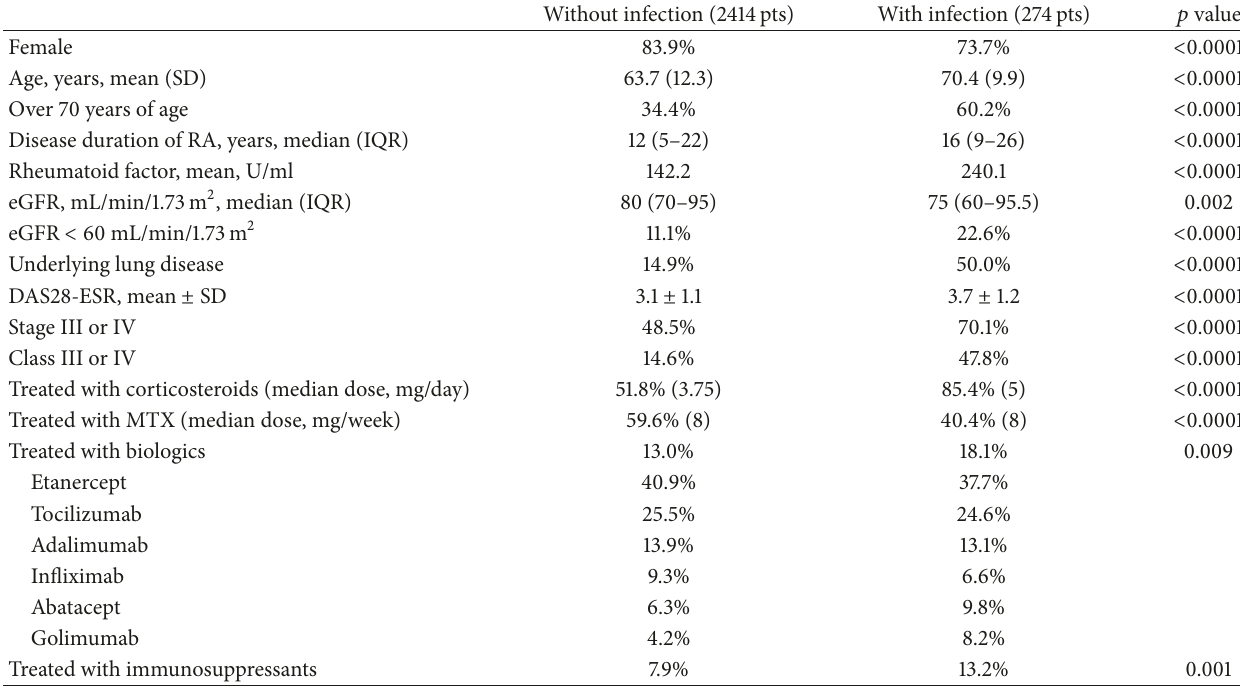
Table 1: Characteristics of patients with or without infections.